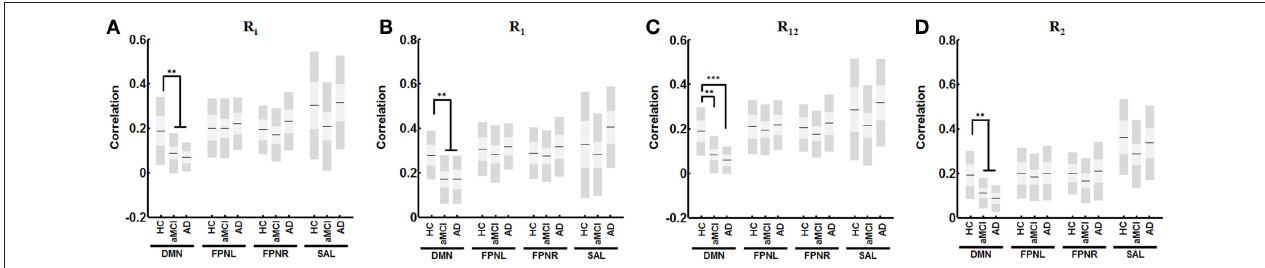
FIGURE 4 | Change in derived functional measures for each network with AD progression. Analysis reveals significant decreased correlation with for R I (A) R 1 (B) , R 12 (C) , and R 2 (D) in the DMN with no changes in FPNL, FPNR, and SAL connectivity. Graph shows mean, SD, and 95% confidence intervals. Lines with asterisks show which groups demonstrated statistical differences: ** α < 0.01, *** α < 0.001. Only connections that are significant after FDR correction for multiple comparison are shown ( α < 0.05).